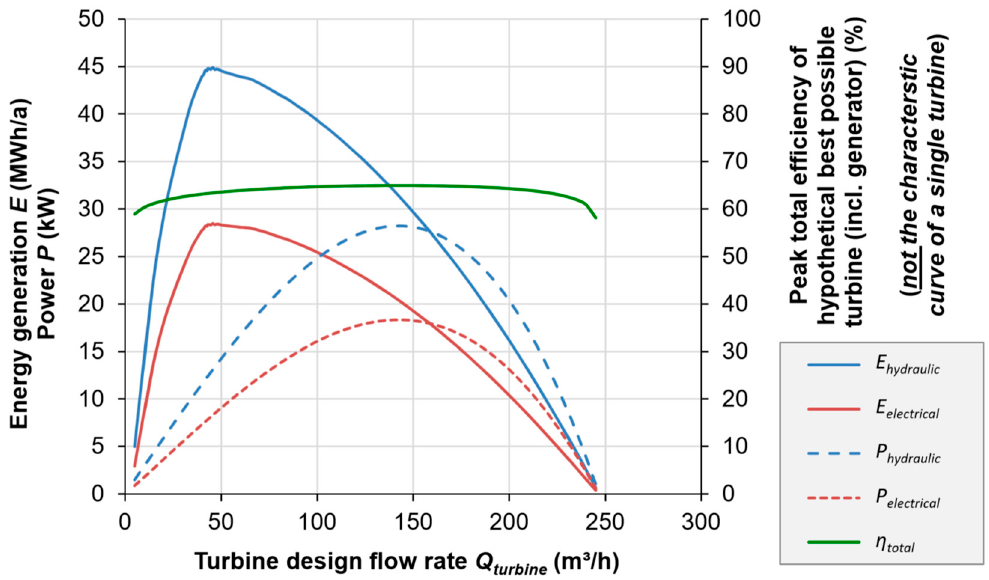
Figure 7. Calculated performance parameters of hypothetical turbines (at best efficiency point) with iteratively varied design flow rates (here from 5 to 245 m 3 /h), with values for BPT Rützengrün.